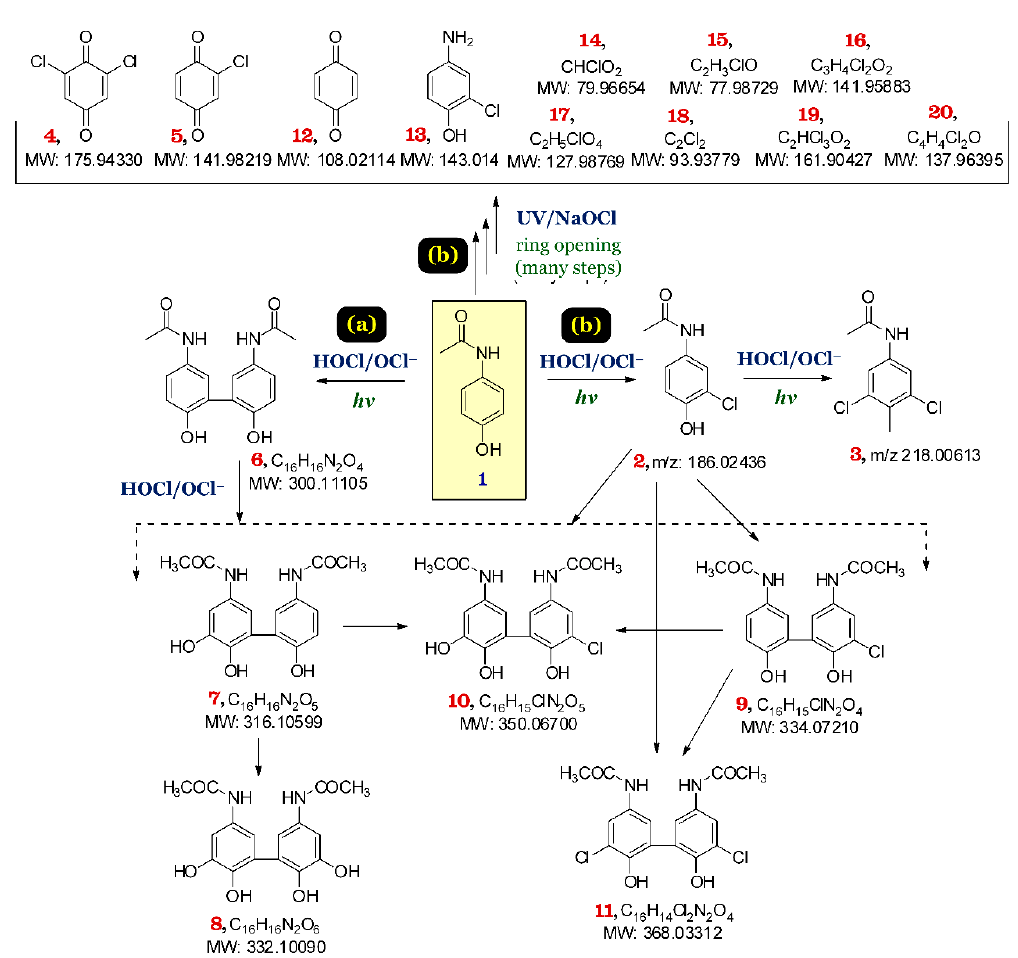
Figure 9. Possible pathways of PRC degradation under the UV/chlorine advanced oxidation process.